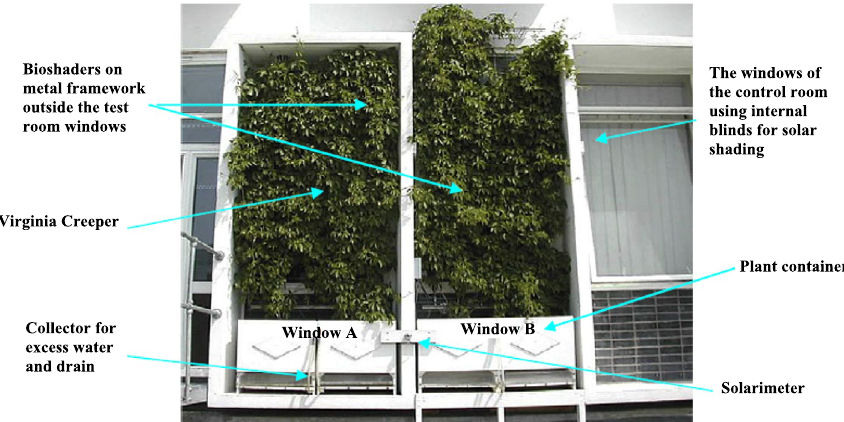
Fig. 5 Bioshader wall in the summer [18]. The units of windows are not covered with plants, and others are covered with plants and the utilized equipment to carry out the Bioshader